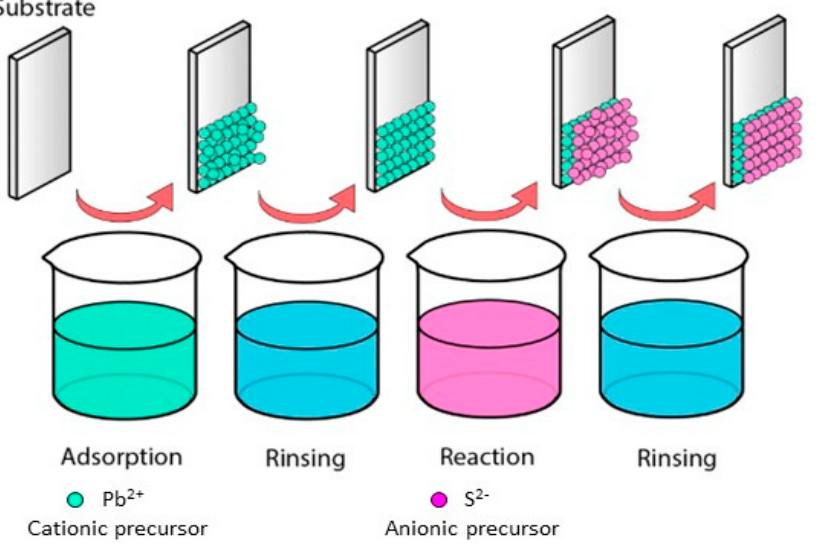
Figure 1. Successive Ionic Layer Adsorption and Reaction process.